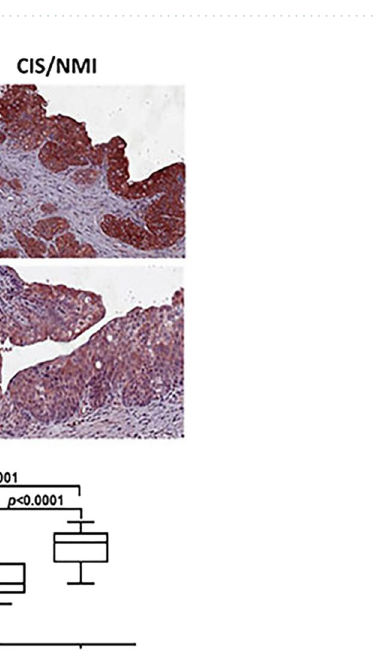
Figure 6. Progressive upregulation of carnitine-conjugated FA in premalignant and early malignant murine bladder lesions. * p < 0.05 compared to normal, and # p < 0.05 comparing premalignant to malignant lesions, one- way ANOVA with multiple comparisons.